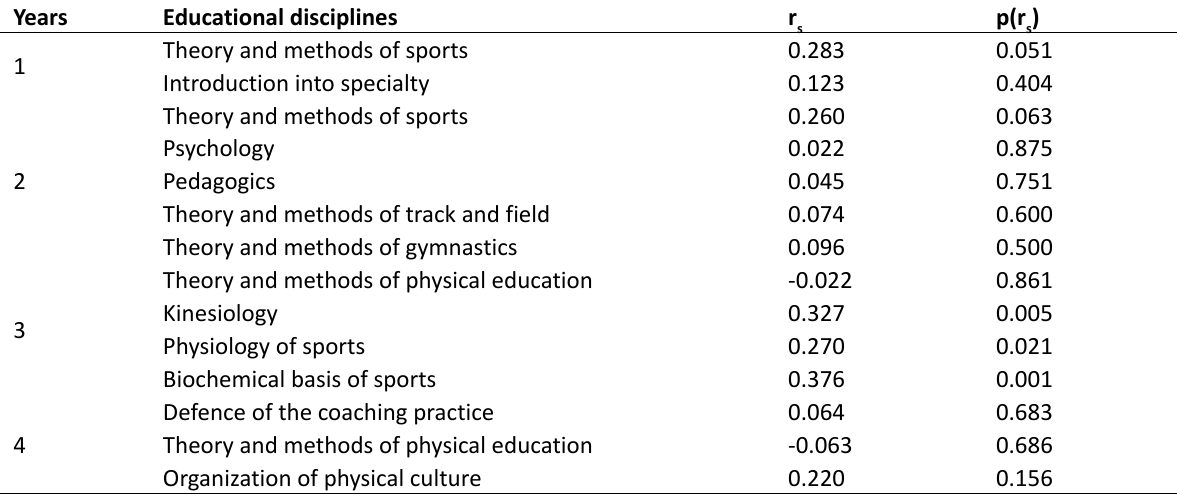
Table 2. Correlation between the educational disciplines scores semester control and sport achievements scores Years